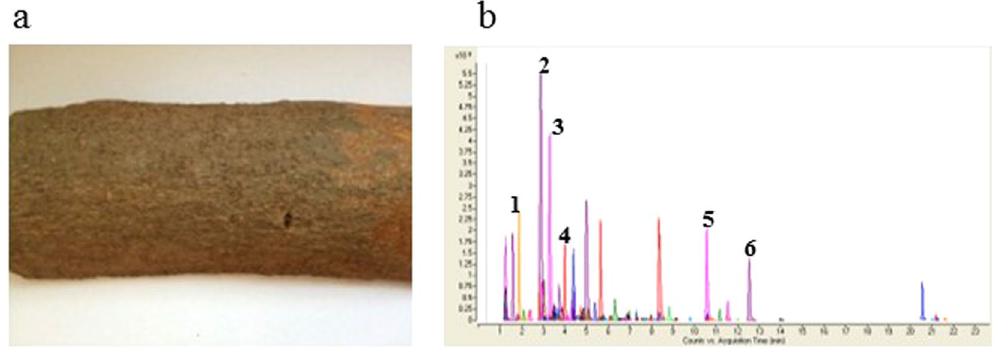
Figure 1. Quality control of cinnamon extract (CE) by HPLC-ESI-MS. ( a ) Cinnamon (bark of Cinnamomum cassia); ( b ) markers for CE: (1) protocatechuic acid, (2) catechin, (3) chlorogenic acid, (4) aesculetin, (5) quercetin and (6)